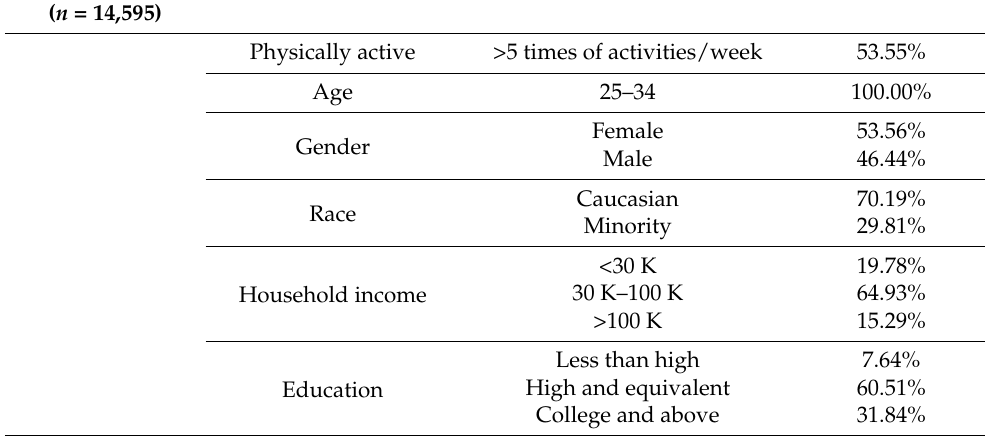
Table 1. The sample